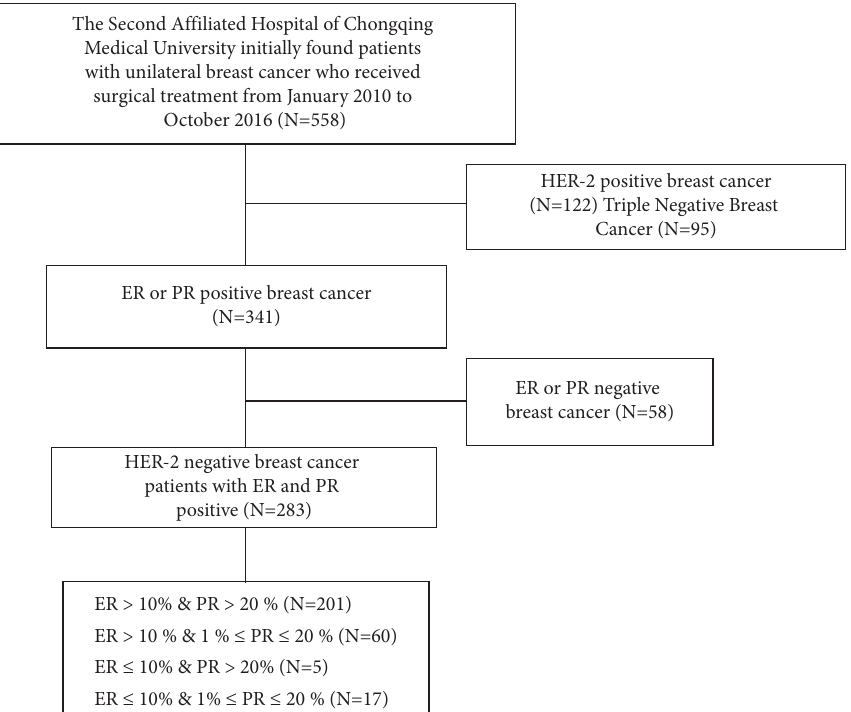
Figure 1: Flow diagram of patients included in this